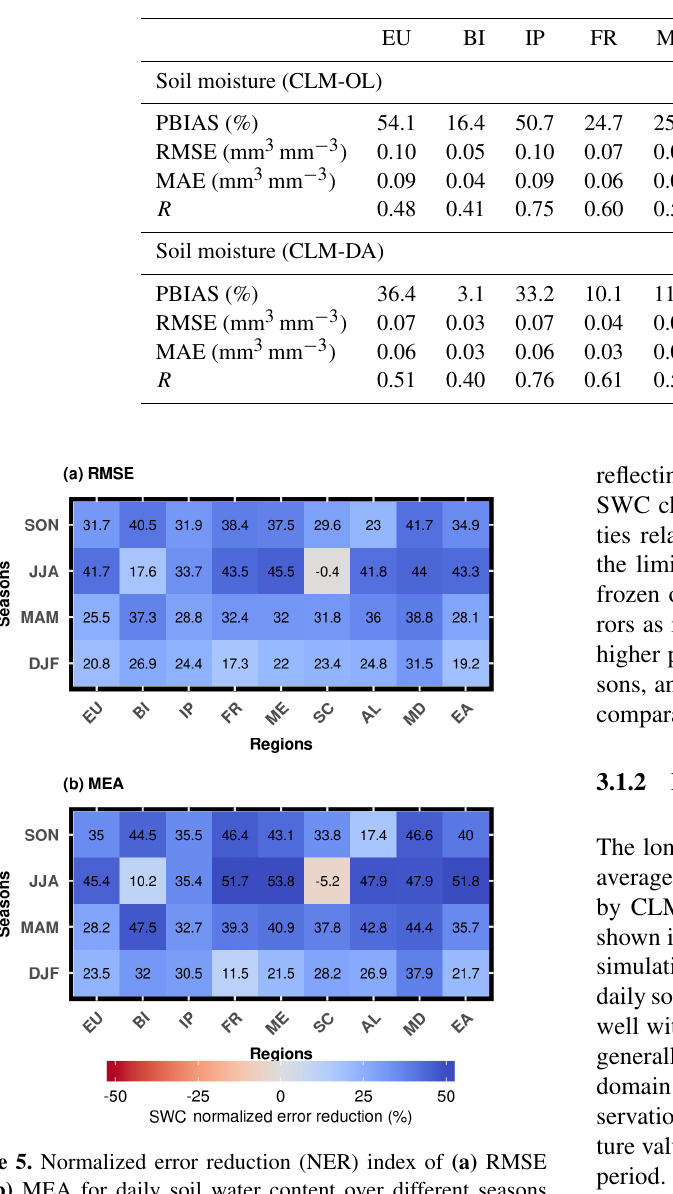
Table 2. Evaluation performance criteria for comparing CLM-OL and CLM-DA with CCI-SM (spatially averaged SWC of surface layer for the EU and PRUDENCE regions).